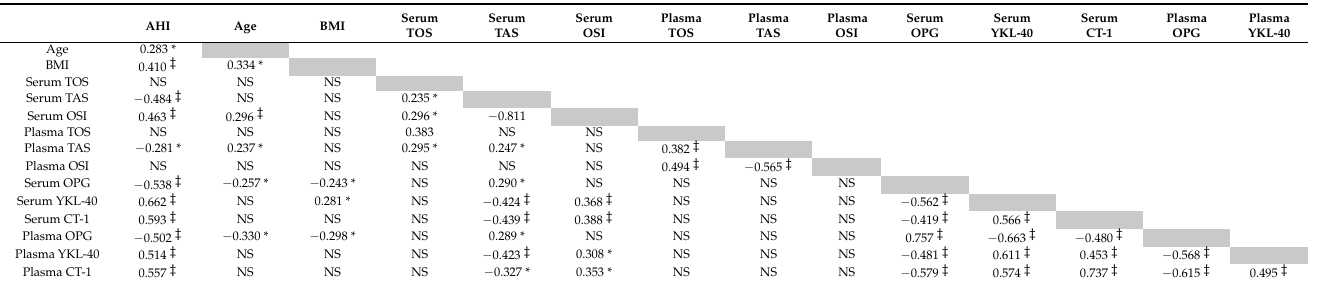
The results of Spearman correlation analysis are expressed as r values and the level of statistical significance ( p ). The values of r with p < 0.05 were considered statistically significant (* p < 0.05, ‡ p < 0.001). Grey background color marks correlations between the corresponding characteristics. NS—not statistically significant ( p > 0.05). BMI, body mass index; AHI, Apnea–Hypopnea Index; TOS, Total Oxidative Status; TAS, Total Antioxidative Status; OSI, Oxidative Stress Index; OPG, Osteoprotegerin; YKL-40, Chitinase-3 like protein-1; CT-1,